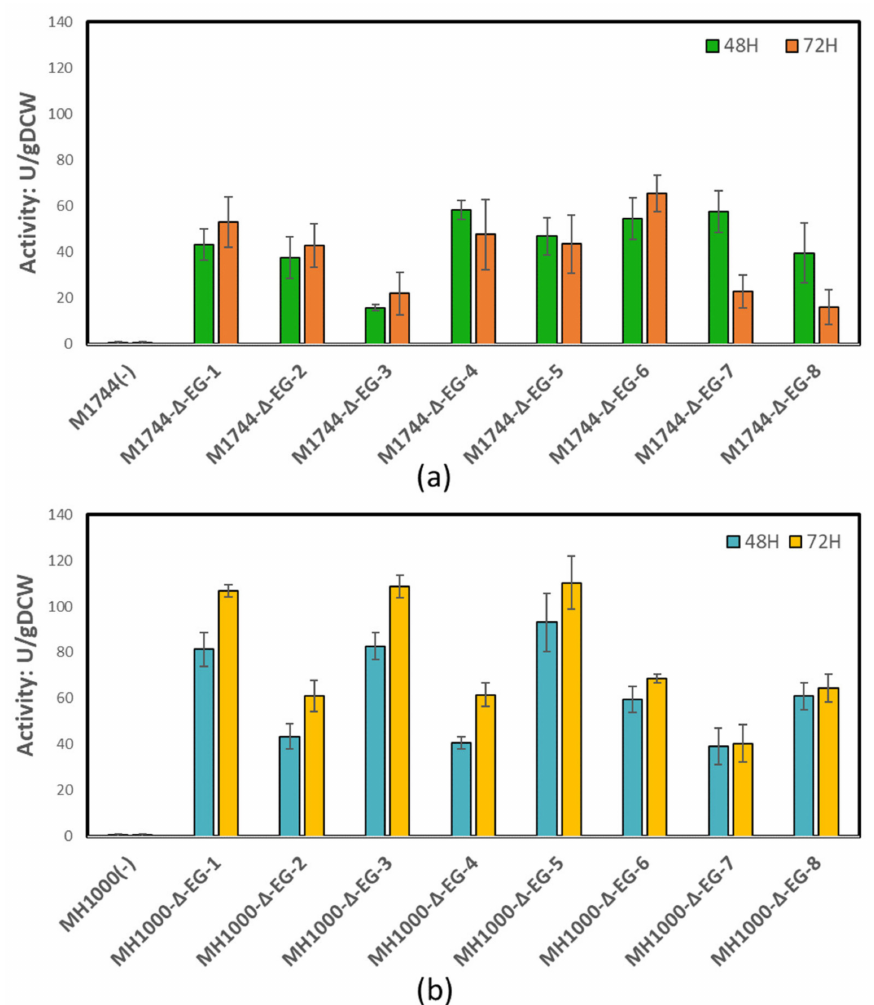
Figure 3. Endoglucanase activity profiles of recombinant yeast strains after 48 and 72 h cultivation. ( a ) The activity of EG2-producing haploid strains and ( b ) diploid strains on CMC. Numbers after the strain names refer to different transformants that were tested. Values obtained were normalized with the dry cell weight of each specific yeast strain. The values given are the mean values of enzyme assays conducted in triplicate. Error bars indicate the standard deviation from the mean